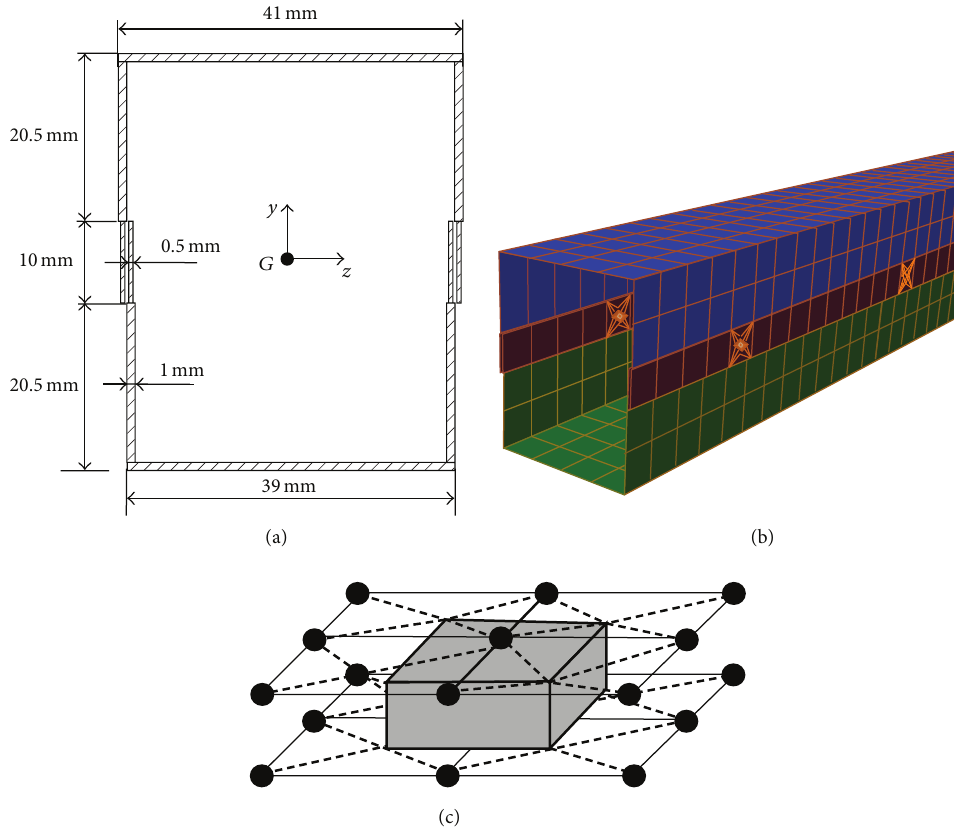
Figure 6: Application model: cross-section geometry of beams (a), mesh of detailed 3D beam model with welding zones (b), and spot weld model, with a central Hexa solid element connected to nodes of flanges by interpolation elements (c).